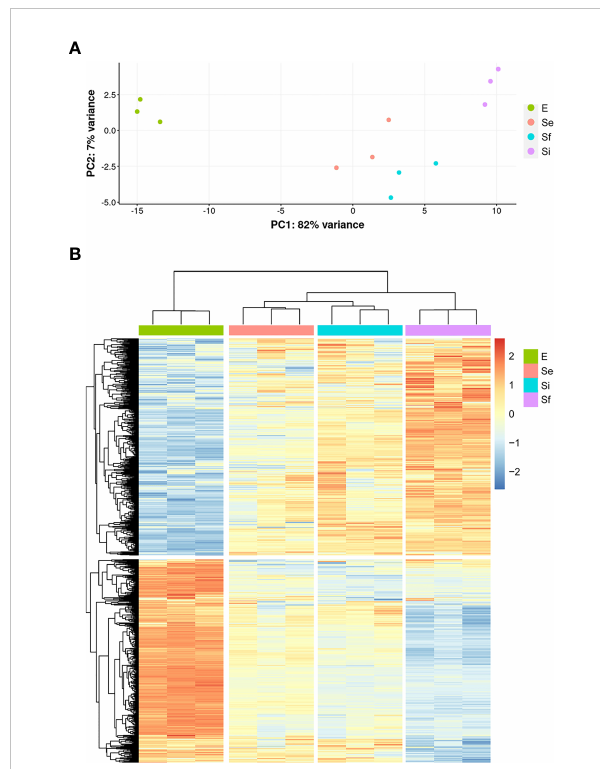
FIGURE 2 Transcriptomic data during prolonged cultures of T. cruzi epimastigotes. Analysis of transcriptomic data derived from polyA +RNA of three independent biological replicates of selected parasite population of the epimastigote long-lasting growth curve: exponentially phase (E) and early, intermediate, and fi nal stationary phase (Se, Si, and Sf, respectively). (A) Principal Component Analysis of individual replicates. (B) Hierarchical clustering of differentially expressed